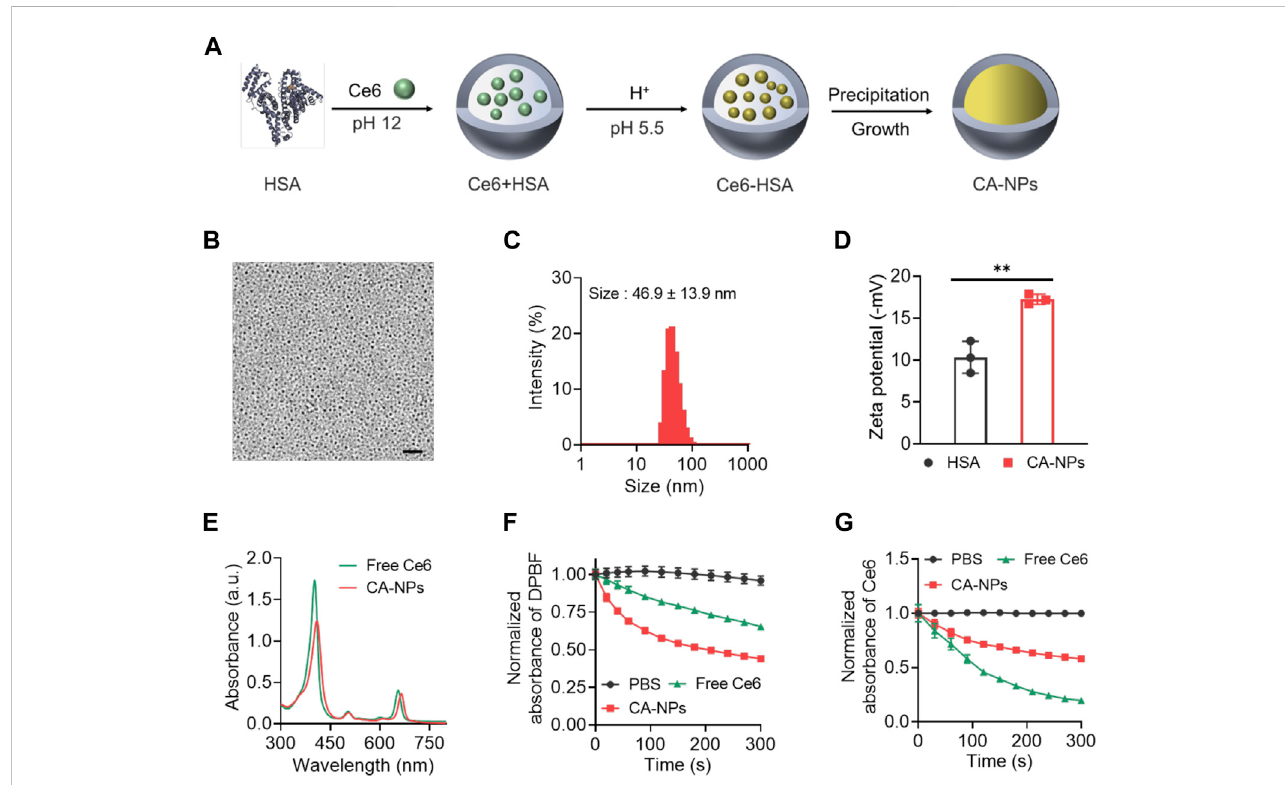
FIGURE 1 SynthesisandcharacterizationofCA-NPs (A) .PreparationofCA-NPsthroughAlbuminNanoreactor. (B) TransmissionelectronmicroscopeimageofCA- NPs. Scale bar: 200 nm. (C) Size distribution of CA-NPs. (D) Zeta potential of HSA and CA-NPs. (n = 3; ** p < 0.01) (E) UV-Vis absorption spectrum of free Ce6 and CA-NPs at the concentration of 5 μ g/ml Ce6. (F) ROS generation of free Ce6 and CA-NPs under 5 min irradiation (660 nm, 0.15 W/cm 2 ) using DPBF as a probe. (G) UV-Vis absorbance of PBS, free Ce6 and CA-NPs under irradiation during 5